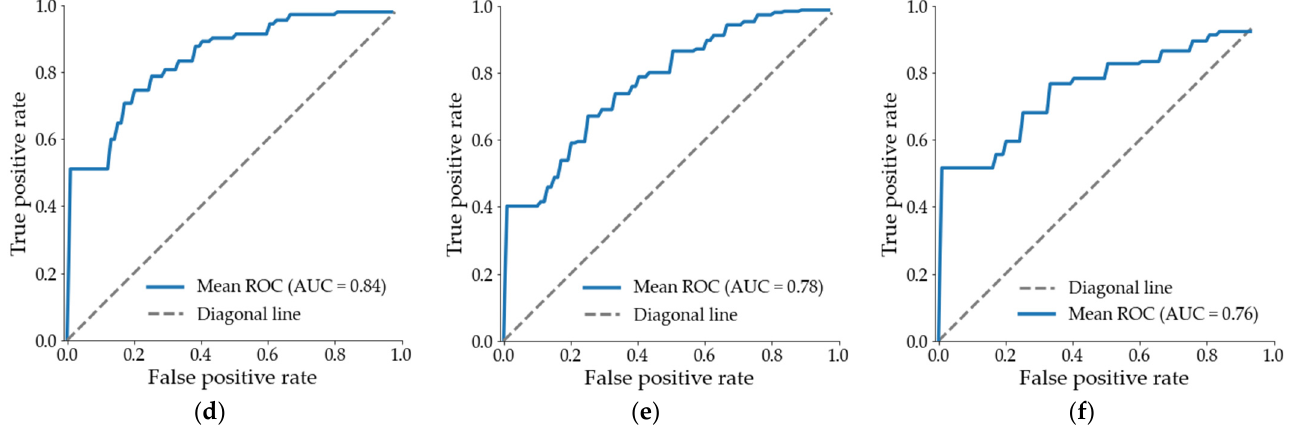
Figure 11. The average ROCs of logistic models on May 8. ( a – f ) The average ROCs of models with spectral features and texture features extracted from window sizes of 5 × 5, 9 × 9, 13 × 13, 17 × 17, 21 × 21, and 25 × 25 pixels.